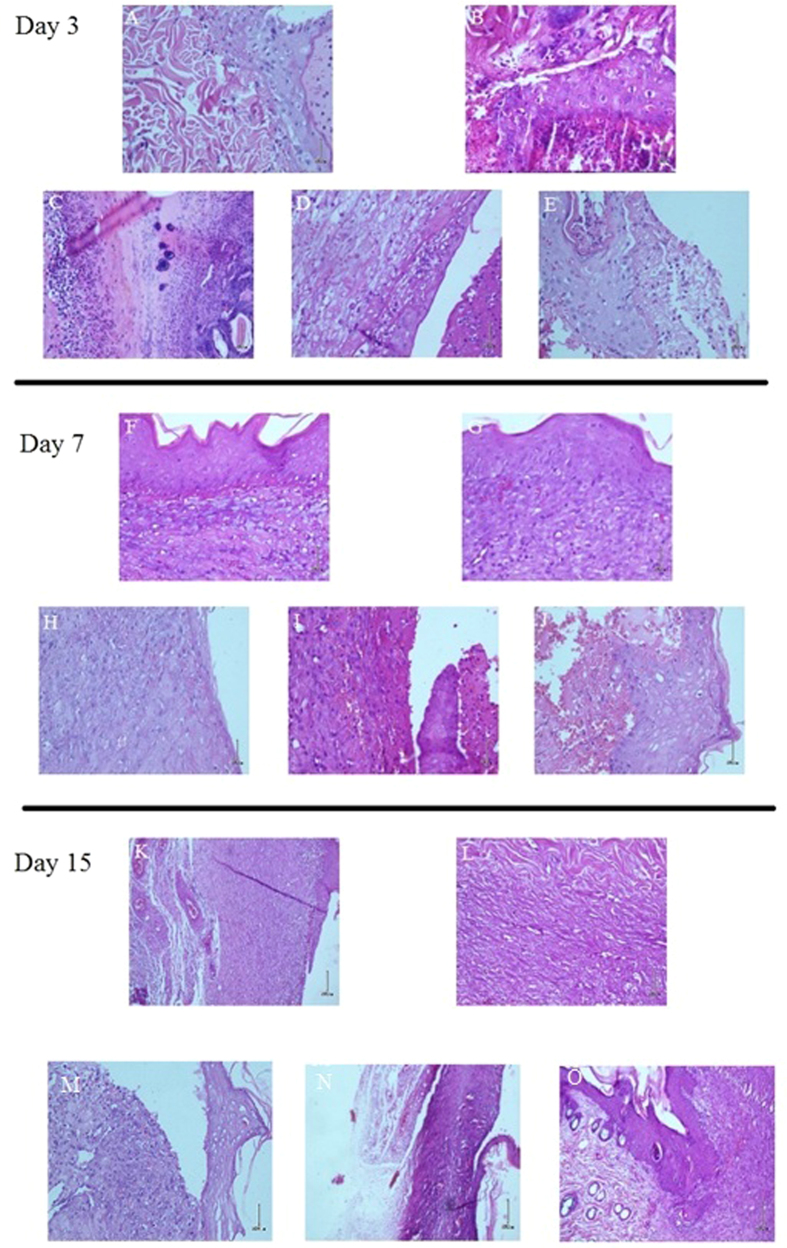
Histological aspect of the rat’s tissue.(A–E) Day 3, (F–J) day 7, (K–O) Day 15. The magnification of the images are 40X. For each day, Top row from left to right :non diabetic-control & non diabetic-plasma treatment. Bottom row from left to right: diabetic-control, diabetic-helium gas treatment & diabetic-plasma treatment.